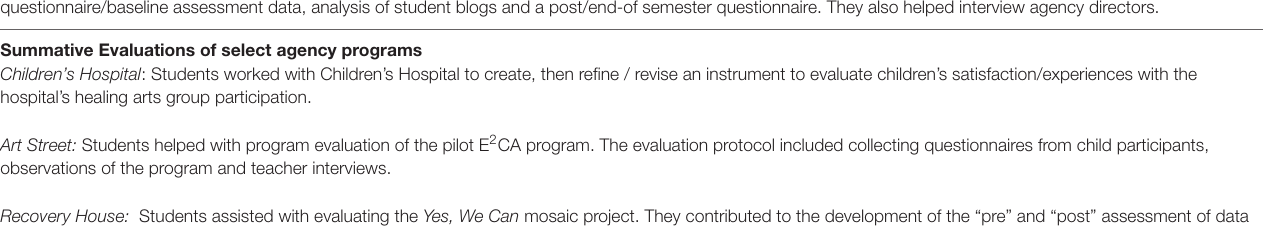
TABLE 3 | Projects Completed by Art Therapy Research Service-Learners in Conjunction with ArtsCorps, Semester 2. Evaluation of Service-learning Experiences of Art History students Students conducted a literature review of service-learning in higher education , and analyzed (AHSL) student experiences with service-learning using pre questionnaire/baseline assessment data, analysis of student blogs and a post/end-of semester questionnaire. They also helped interview agency